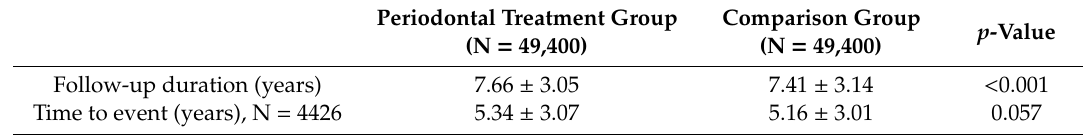
Table 4. Hazard ratios of pneumonia development among different periodontal treatments.